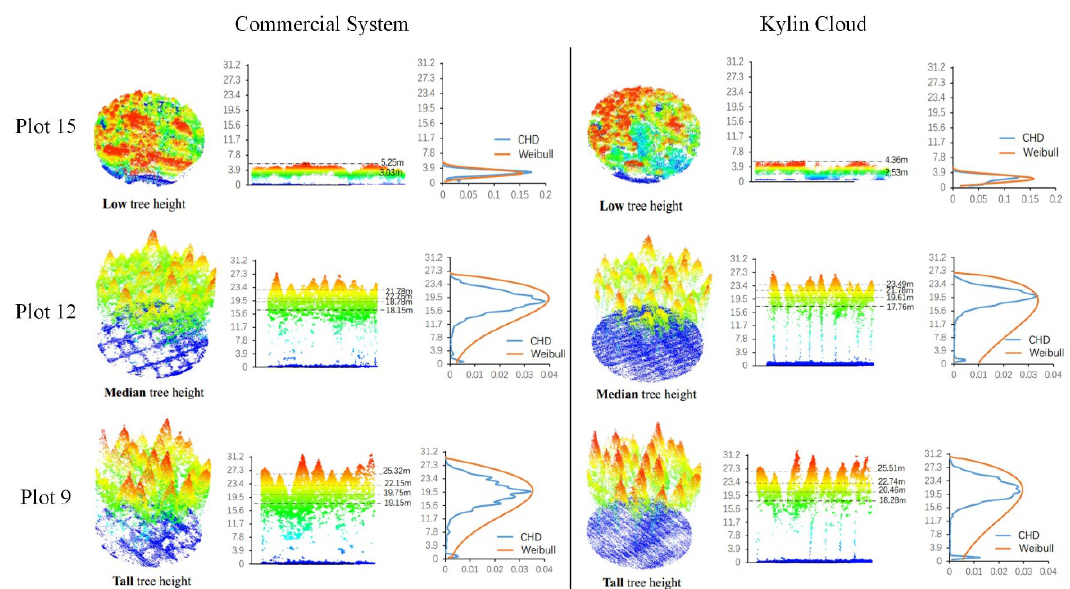
Figure 12. Comparison of point clouds from different platforms and canopy height distribution (CHD) in three plots with different heights.